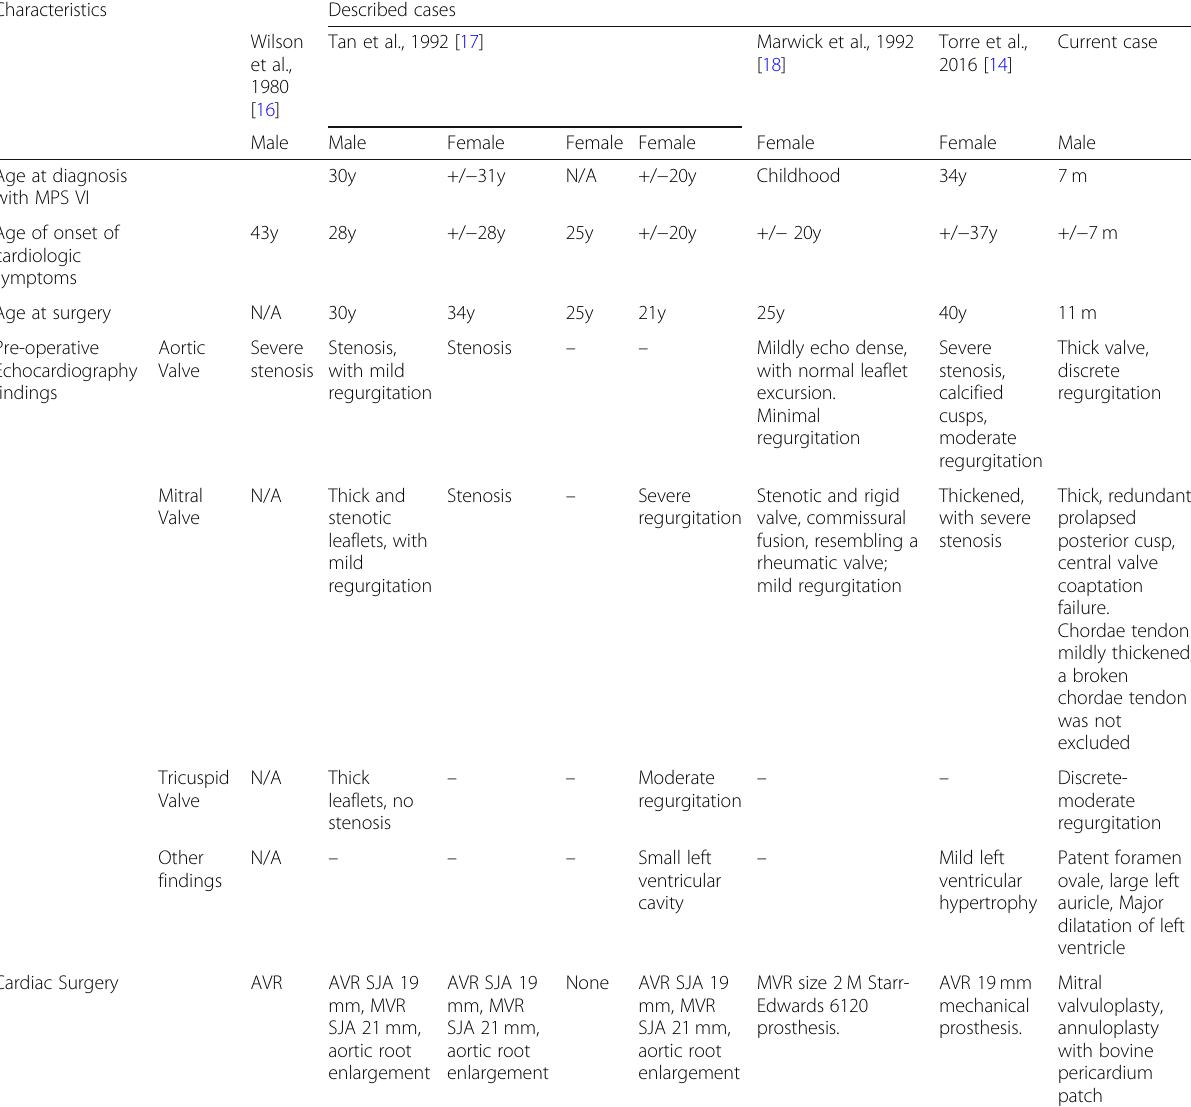
Table 1 Patients reported in the literature diagnosed with MPS VI who had undergone